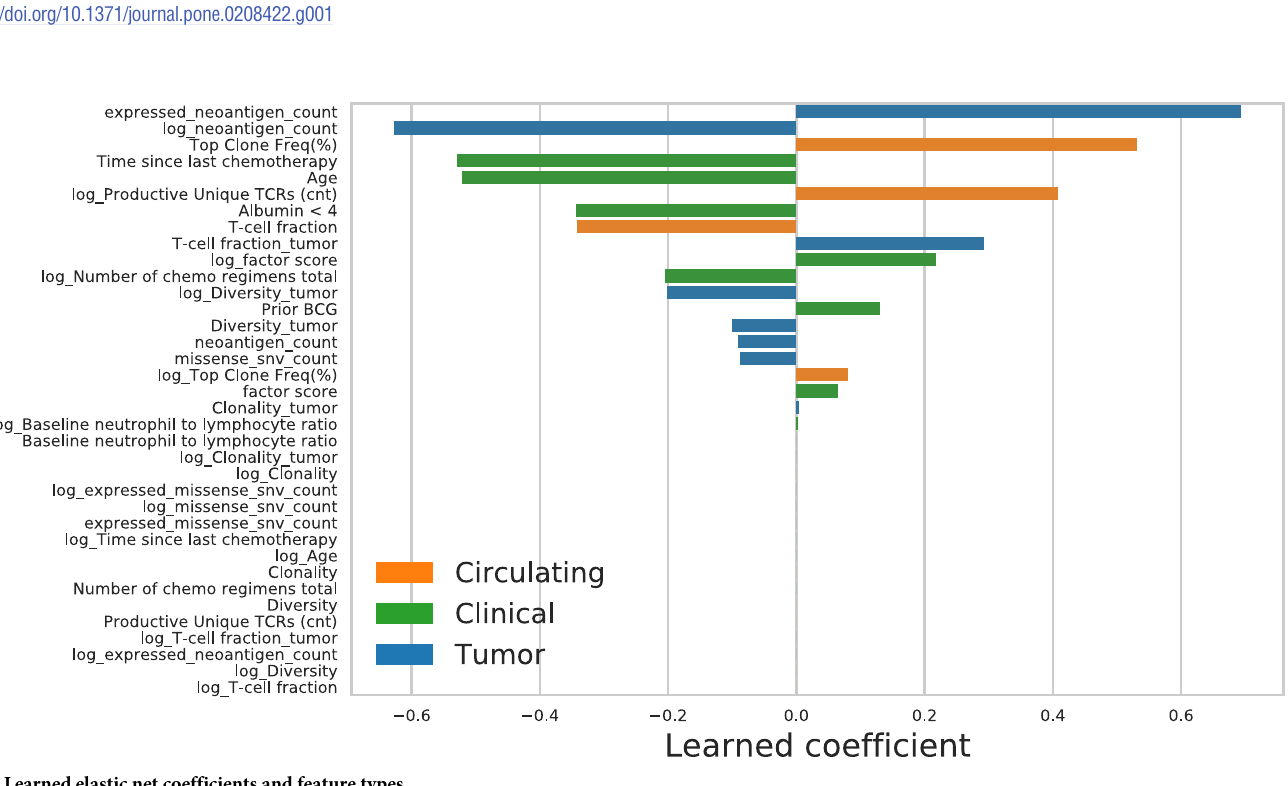
Fig 1. (A) Predicted log TIL expansion versus ground-truth log TIL expansion for patients held out using LOOCV. Predictions are formed using the elastic net. (B) Histogram of LOOCV error when patient responses are permuted uniformly at random 1000 times. The overlaid dotted line displays the LOOCV error obtained on the original dataset.